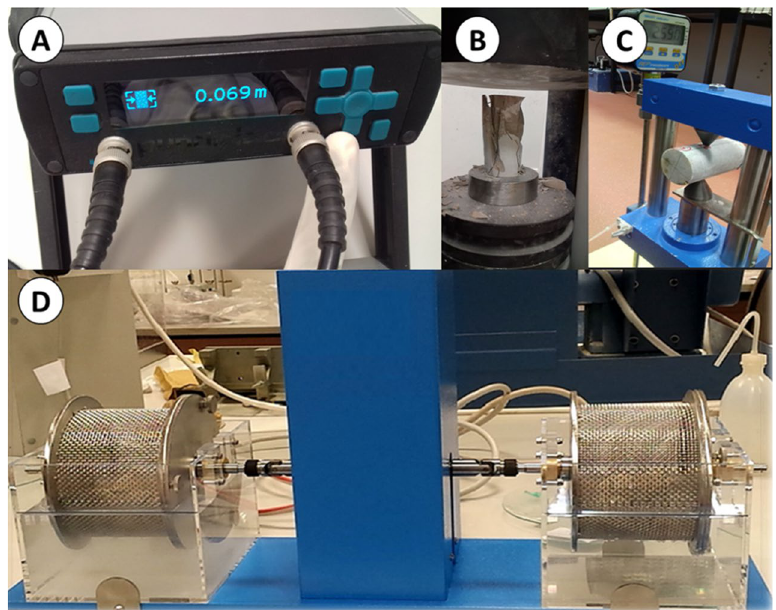
Figure 3. Laboratory equipment used for ( A ) V p measurements, Pundit Lab, ( B ) UCS test, servo plus evolution press ( C ) PLI test, and ( D ) SDI